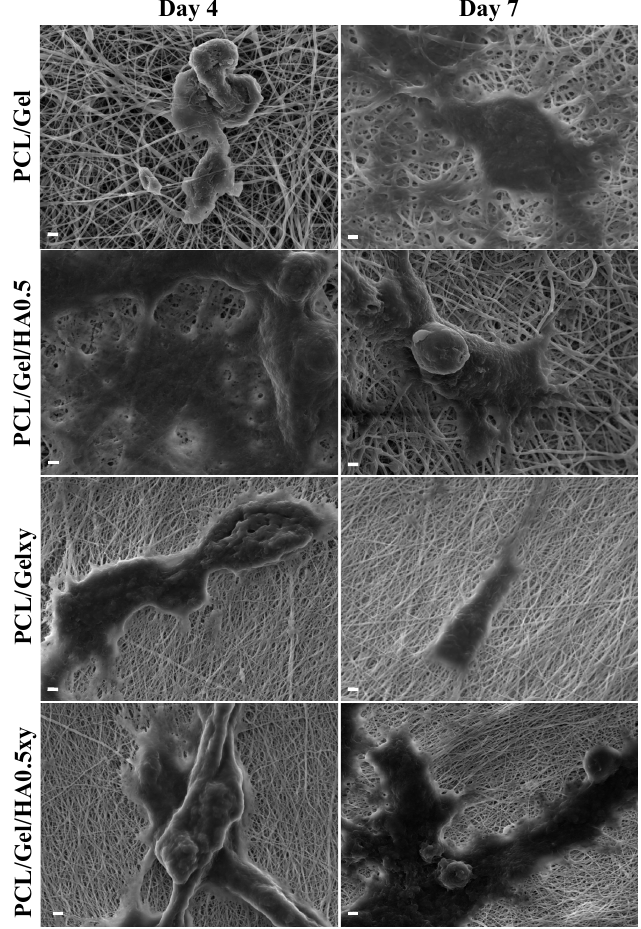
Figure 8. SEM images of U251 cells attached to scaffolds after 4 and 7 days of incubation (scale bar: 2 μ m).